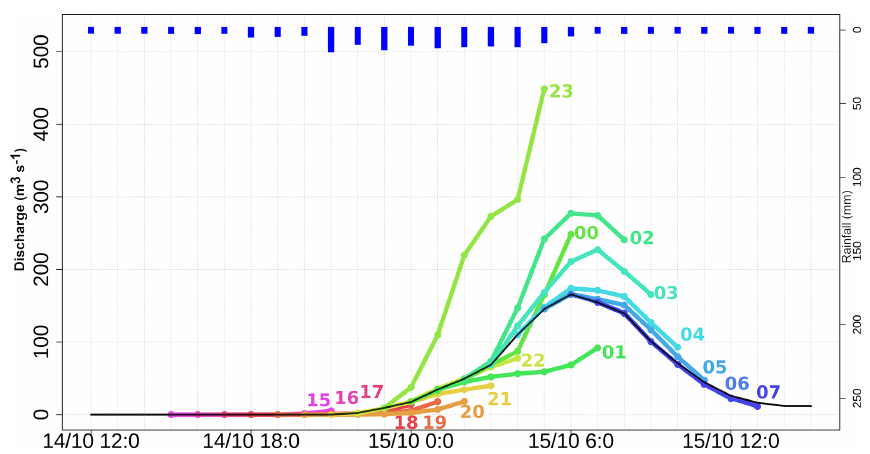
Figure 12. Discharge time series simulated by ISBA-TOP driven by ANTILOPE rainfall estimates (black curve) and by AROME-NWC forecasts (coloured curves with forecasts starting from 14 October 15:00UTC to 15 October 07:00UTC) for the Fresquel river at Pezens (watershed No. 1). The reverse histogram represents the ANTILOPE hourly rainfall averaged over the